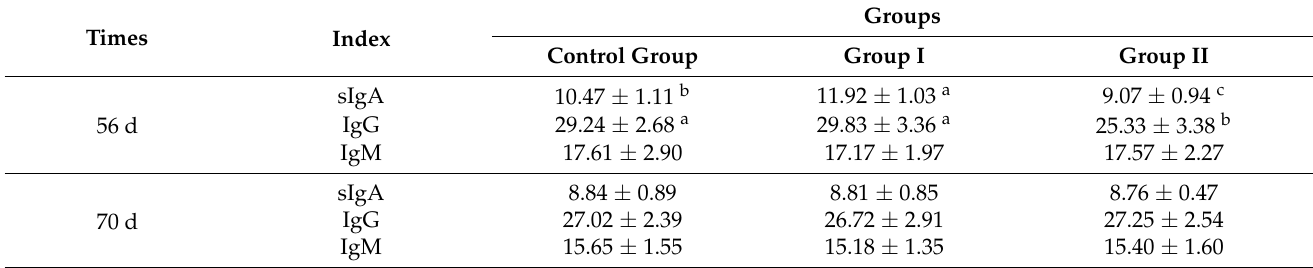
Table 7. Effects of feed restriction and compensation on immune indexes in rabbits (mg/g).